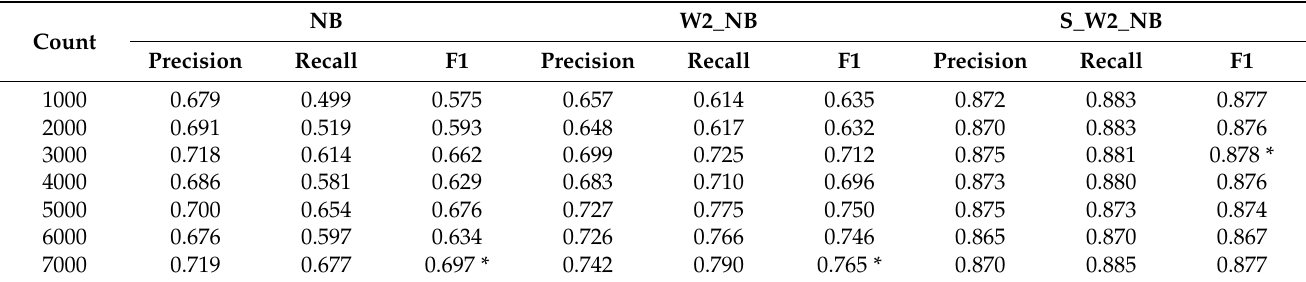
Table 4. The comparison of classification algorithms.